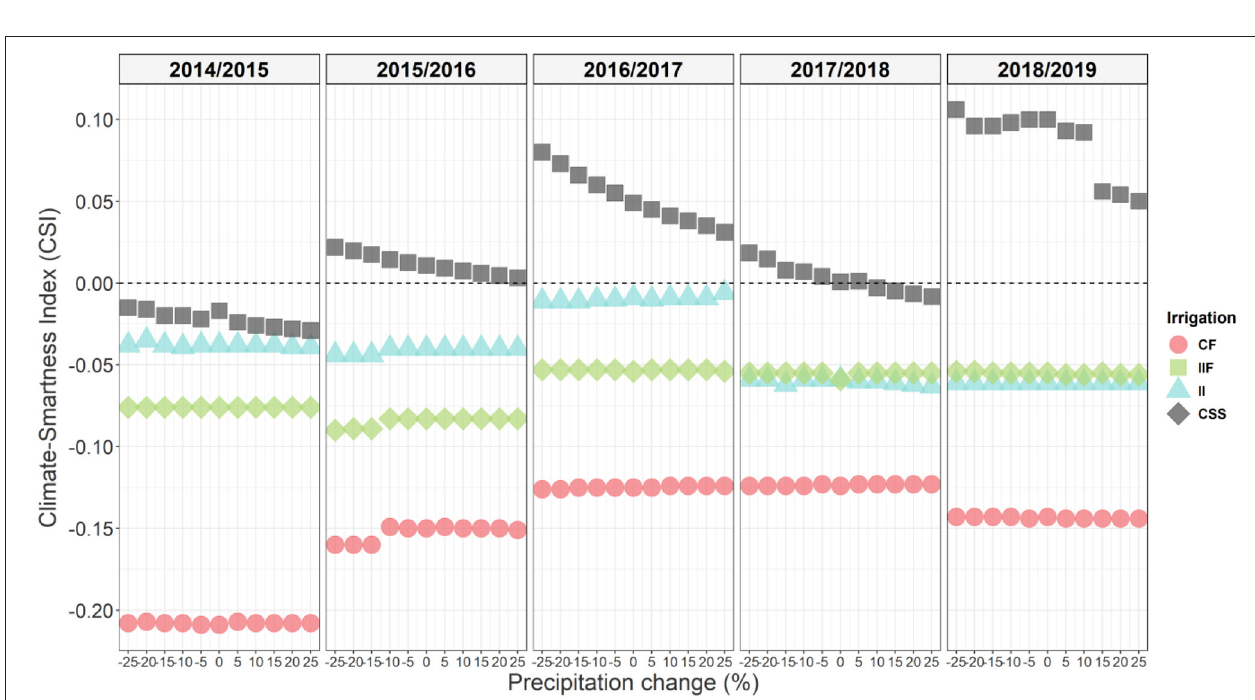
FIGURE 8 | Sensitivity of Climate-Smartness Index (CSI) to changes on rainfall of rice crop under Continuous flooding (CF), Intermittent irrigation until flowering (IIF), intermittent irrigation (II) and Continuous soil saturation (CSS) treatments.